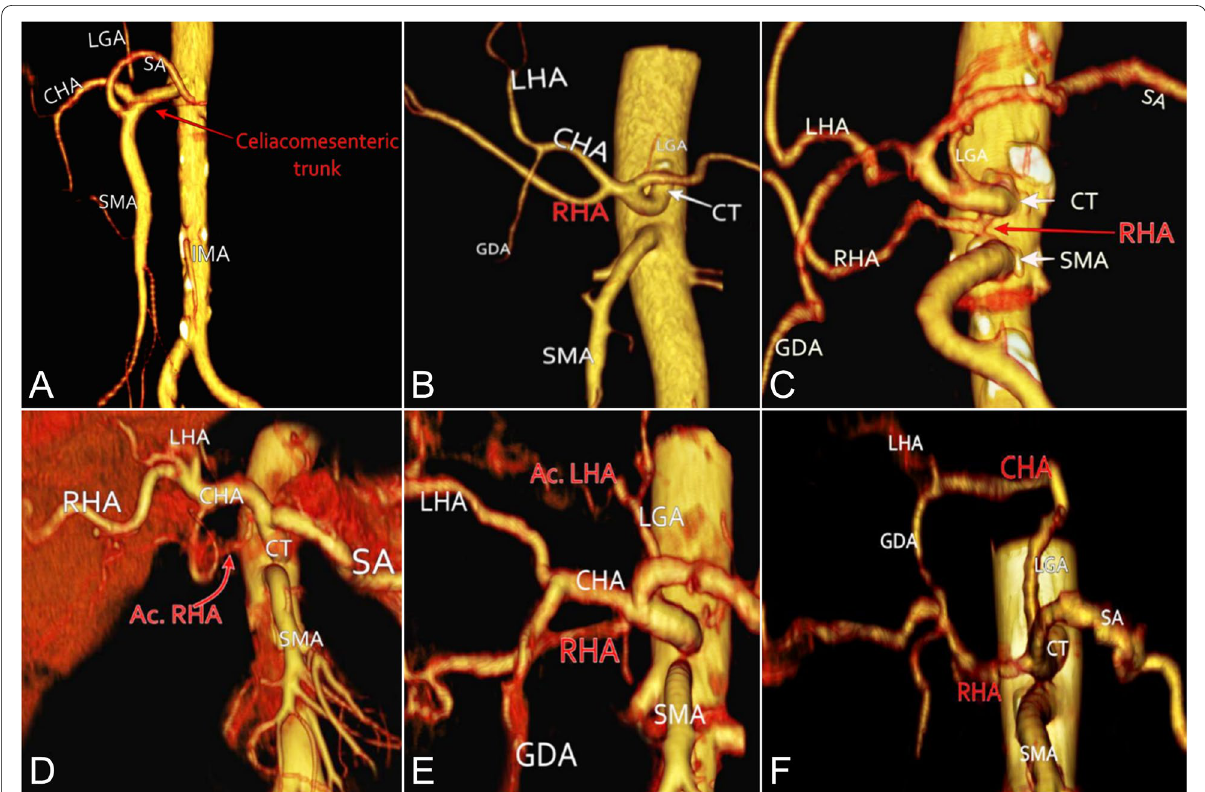
Fig. 2 3-dimensional reconstruction of the rare hepatic artery variants. A Celiacomesenteric trunk. B Replaced right hepatic artery (RHA) from the celiac trunk. C Replaced RHA arising from aorta separately. D Accessory RHA from the celiac trunk. E Replaced RHA from the celiac trunk and accessory left hepatic artery (LHA). F Replaced RHA from the celiac trunk and common hepatic artery (CHA) from left gastric artery